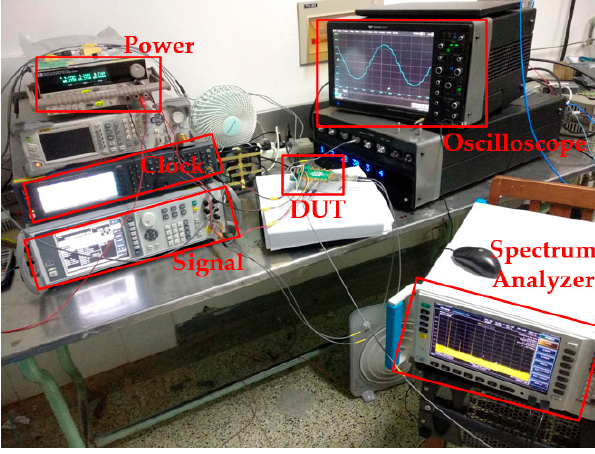
Figure 10. Measurement setup.